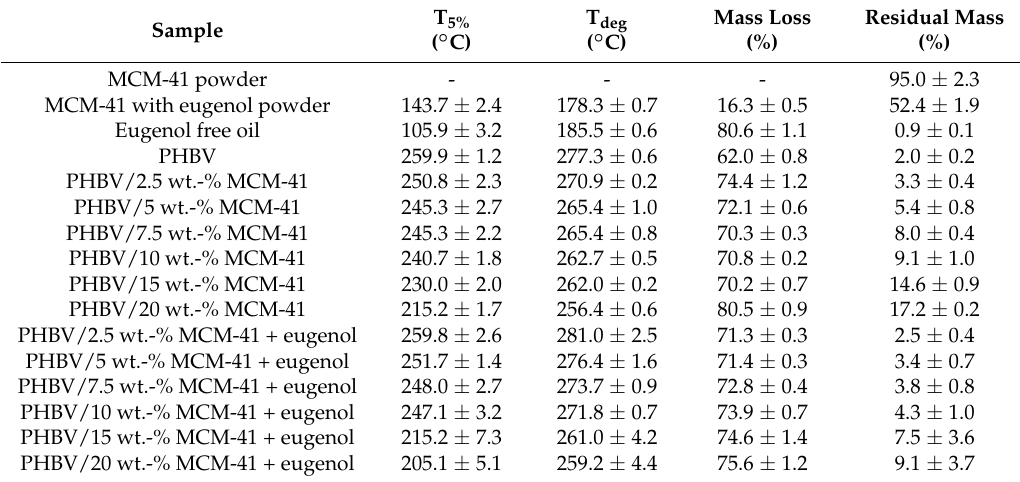
Table 3. Thermal properties in terms of mass loss was 5% (T 5% ), degradation temperature (T deg ), mass loss at T deg , and a residual mass at 800 ◦ C for Mobil Composition of Matter (MCM)-41, MCM-41 with eugenol, eugenol free oil, and electrospun films of poly(3-hydroxybutyrate- co -3-hydroxyvalerate) (PHBV) and PHBV/MCM-41 without and with